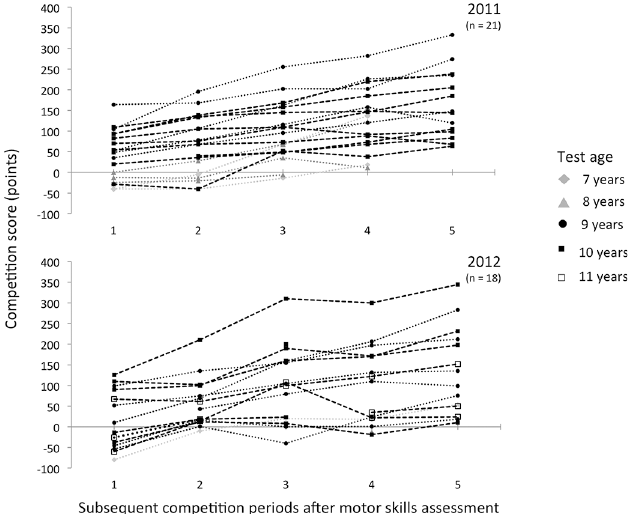
Fig 1. Competition score curve per player over five competition periods (= 2.5 years). Lines represent the individual